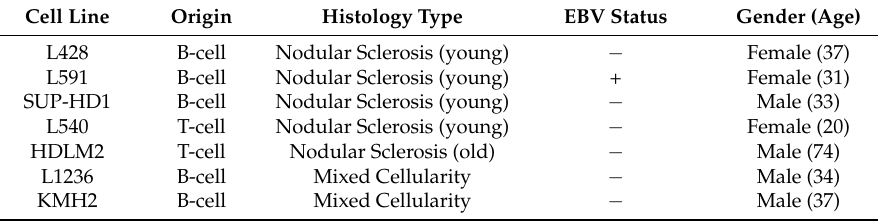
Table 2. Origins, histological types, and EBV status of the HL cell lines used in this